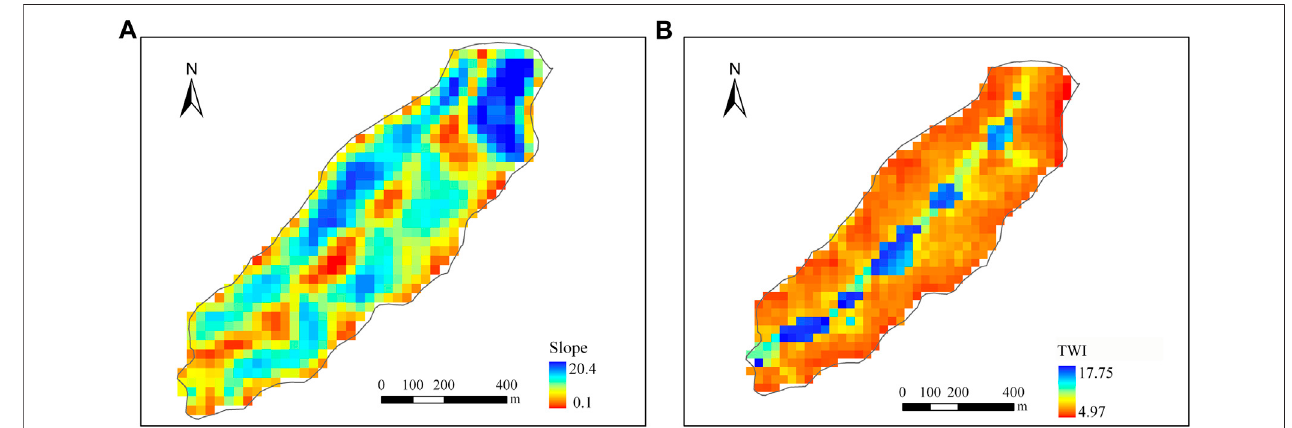
FIGURE 11 | Spatial distribution of slope (A) and TWI (B) of Kendall watershed.